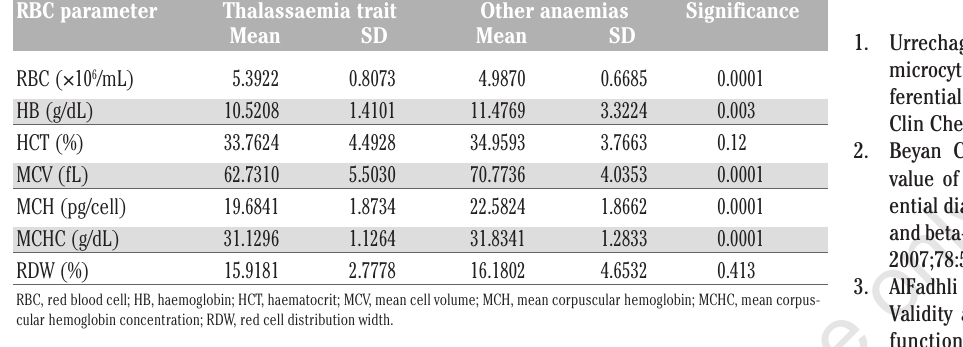
Table 1. The significance of red blood cell parameters between β -thalassaemia trait and other microcytic anaemias.